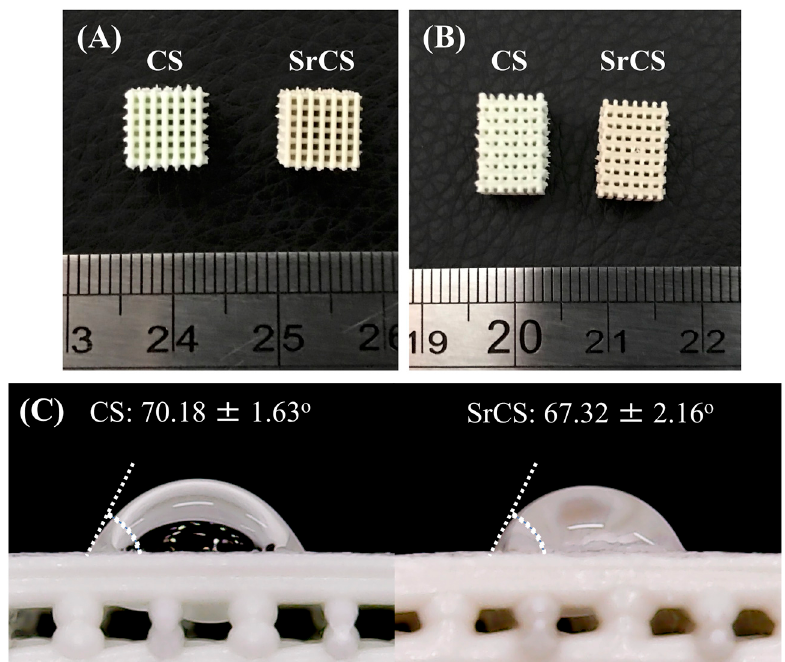
Figure 1. Top view ( A ) and lateral view ( B ) of the printed CS and SrCS scaffolds. Water contact angle of ( C ) CS sand SrCS scaffold. Data presented as mean ± SEM, n = 6 for each group.